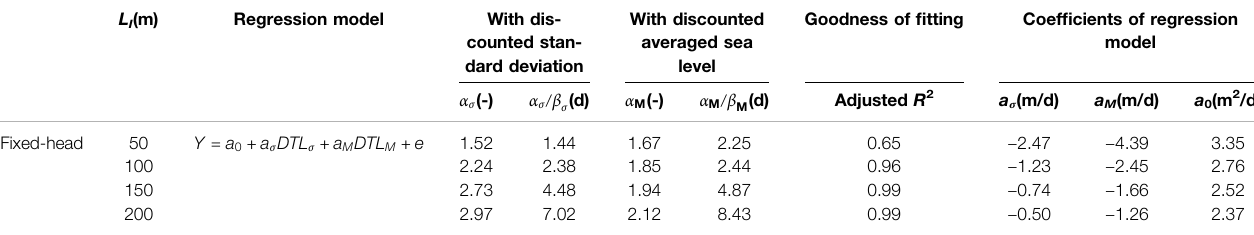
TABLE 3 | Summary of regression results for inland freshwater input a